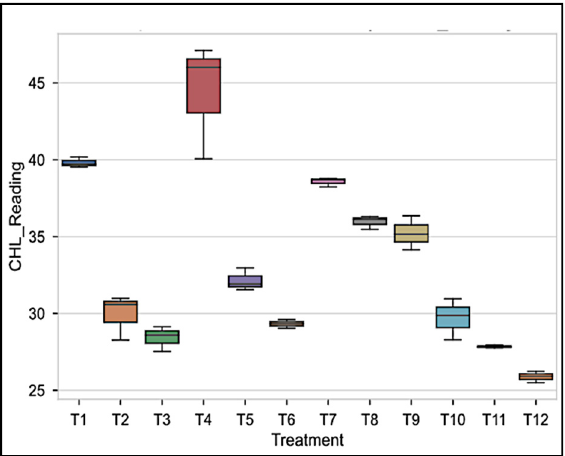
Figure 4. Comparison of the box plots for one way ANOVA.